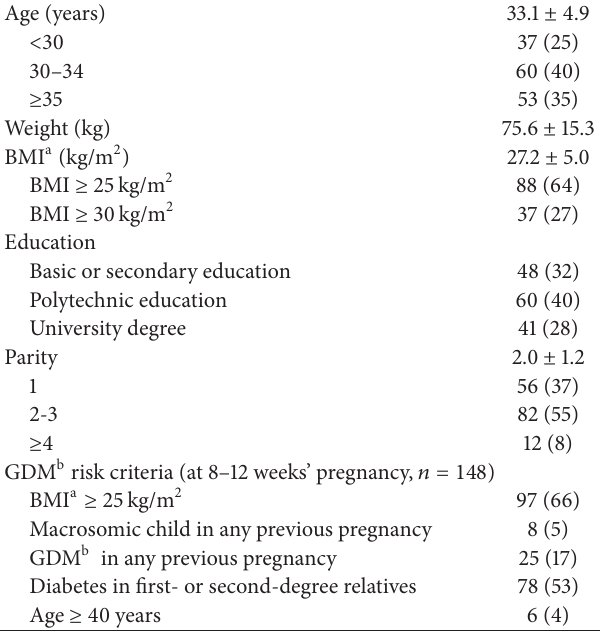
Table 1: Background characteristics of women at one year postpar- tum. Means and standard deviations or frequencies (and propor- tions) of participants ( 𝑛 = 150